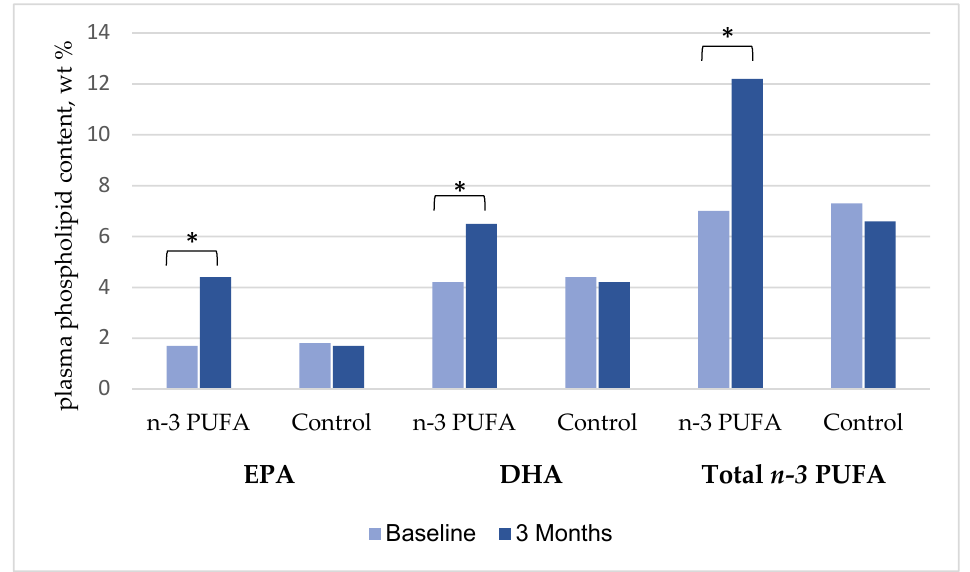
Figure 2. Plasma phospholipid content of EPA, DHA, and total n -3 PUFA (EPA + DHA + DPA) at baseline and after three months supplementation of 2 g n -3 PUFA. Significant changes are marked by * ( p < 0.0001). EPA, eicosapentaenoic acid; DHA, docosahexaenoic acid; PUFA, polyunsaturated fatty acids; DPA, docosapentaenoic acid.